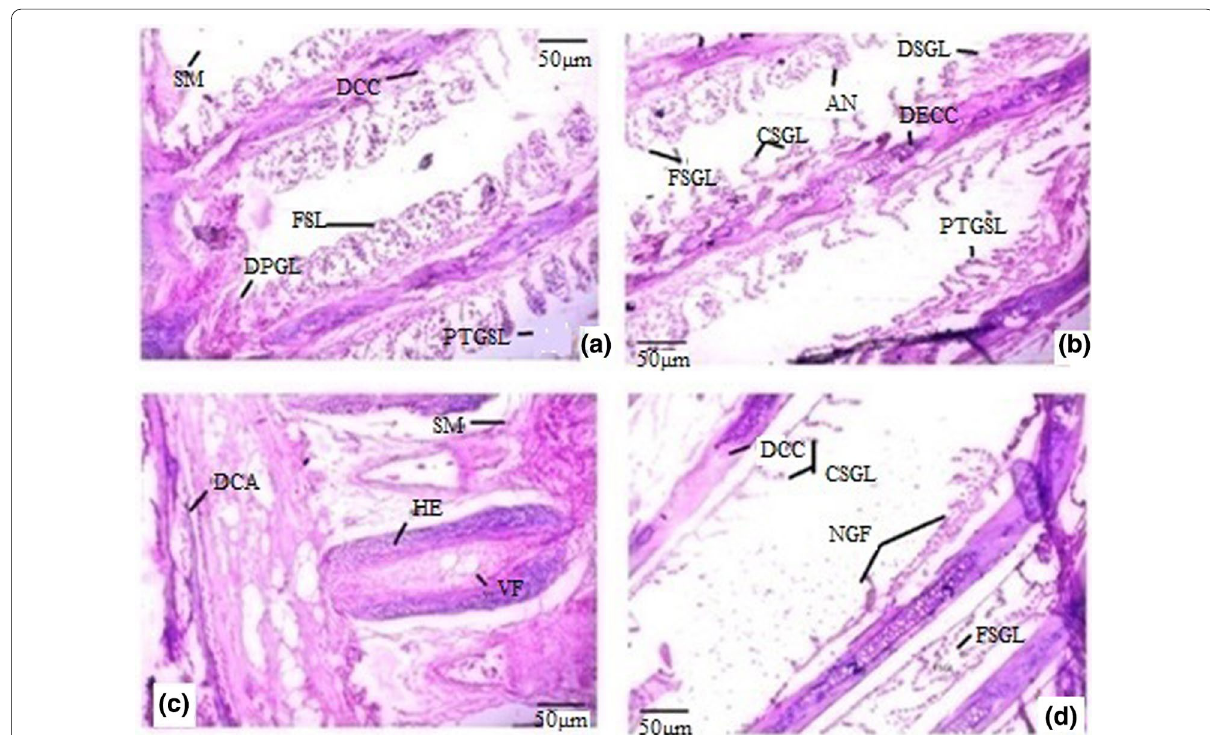
Fig. 5 a Infested gill showing secretions of mucus (SM), fusion of secondary gill lamella (FSGL), degeneration of primary gill lamella (DPGL), proliferated tips of secondary gill lamella (PTGSL). b Infested gill with curling of secondary gill lamella (CSGL), fusion of secondary gill lamella (FSGL), damaged central core (DCC), proliferated tips of secondary gill lamella (PTGSL). c Infested gill showing degeneration of central axis (DCA), secretion of mucus (SM), vacuole formation (VF), hyperplasia of epithelial cells (HE). d Infested gill showing necrosis of gill filaments